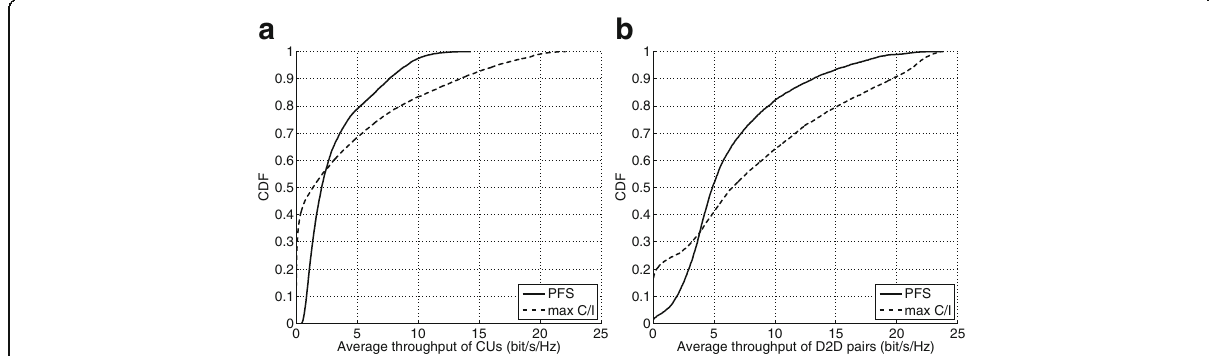
Fig. 6 CDF of average throughput for PFS and max C/I. a CUs. b D2D pairs